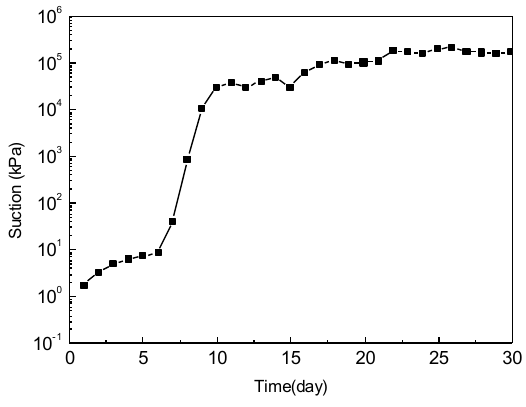
Figure 7b. Variation of the suction at the soil surface (Case study)